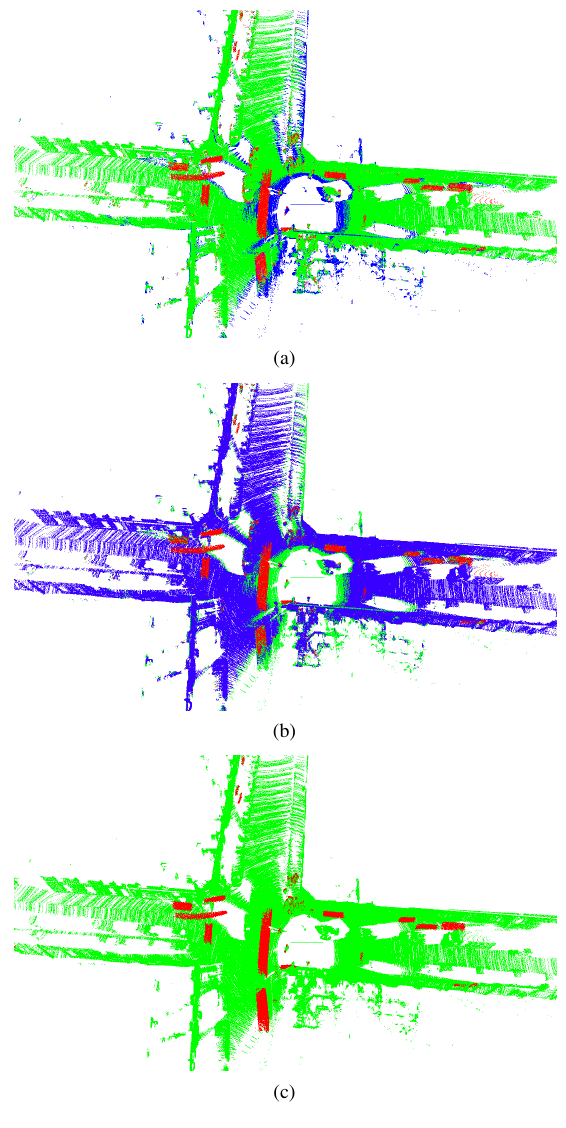
Figure 9. Moving object detection with point normals using a mobile laser scanner. (a) DST approach (R:moving, G:static, B:uncertain); (b) Probability approach (R:moving,